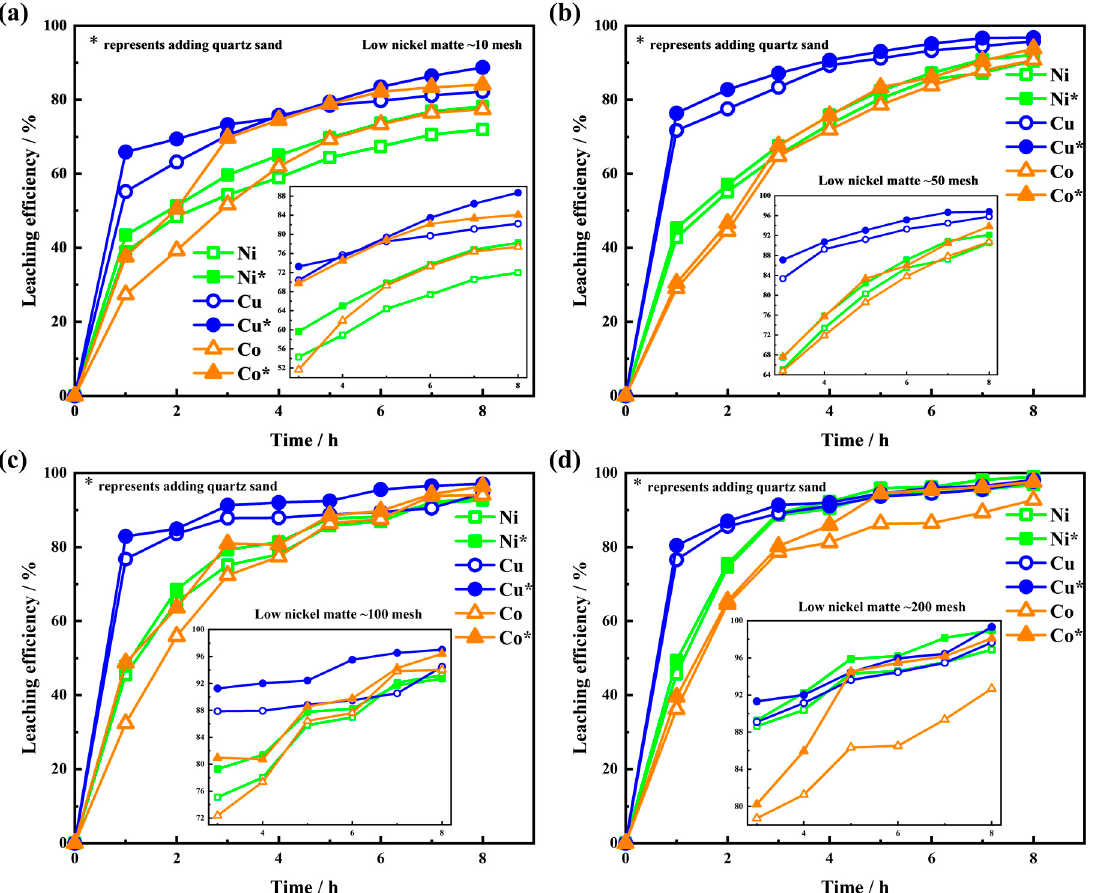
Figure 9. Leaching efficiency of the low-nickel matte with different particle sizes: ( a ) Leaching efficiency of Ni, Cu, and Co from the low-nickel matte with particle size of around 1700 µ m (~10 mesh); ( b ) leaching efficiency of Ni, Cu, and Co from the low-nickel matte with particle size of around 270 µ m (~50 mesh); ( c ) leaching efficiency of Ni, Cu, and Co from the low-nickel matte with particle size of around 150 µ m (~100 mesh); ( d ) leaching efficiency of Ni, Cu, and Co from the low-nickel matte with particle size of around 75 µ m (~200 mesh). (The illustration is a partial magnification and * represents adding quartz